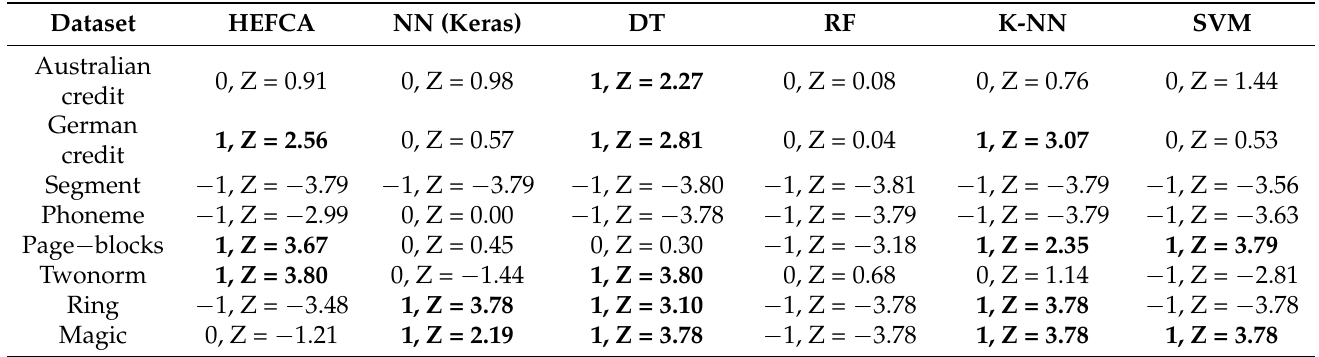
Table 8. Mann–Whitney statistical tests of NEAT-DBM compared to alternative approaches, test